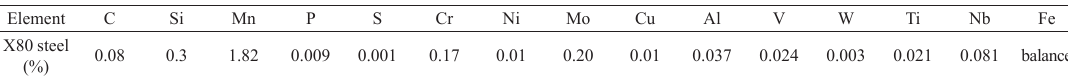
Table 1. Chemical composition of X80 steel (%).